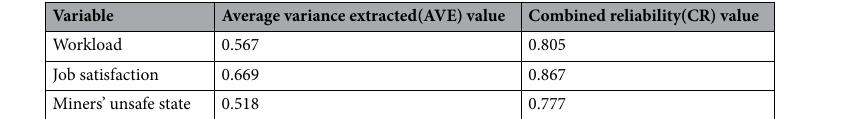
Table 3. Model AVE and CR metrics results.